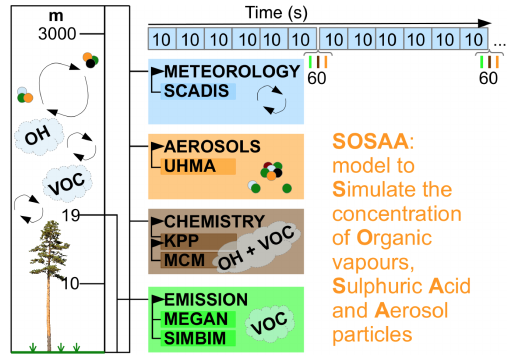
Figure 1. The model structure of SOSAA: SCADIS describes the meteorological evolution of the vertical domain, followed by either MEGAN or SIMBIM that provide emissions of VOCs from the individual levels of the canopy. Chemical reactions are chosen from the MCM and processed by the KPP whereafter aerosol dynamical processes are calculated by UHMA.